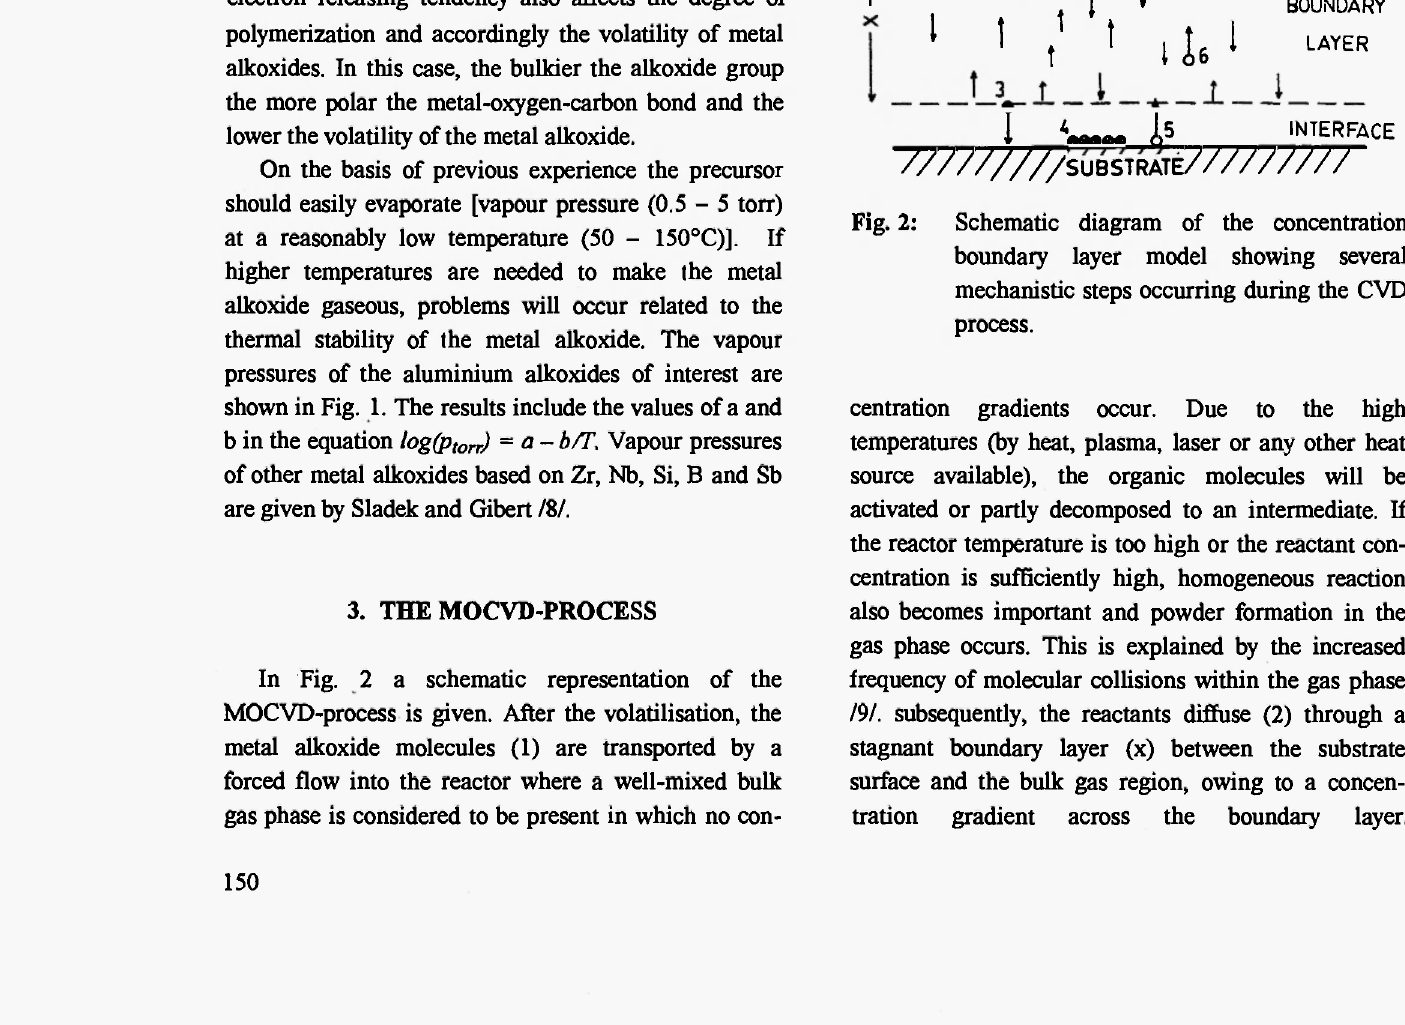
Fig. 1: The vapour pressure of aluminium alkoxides as a function of the temperature.